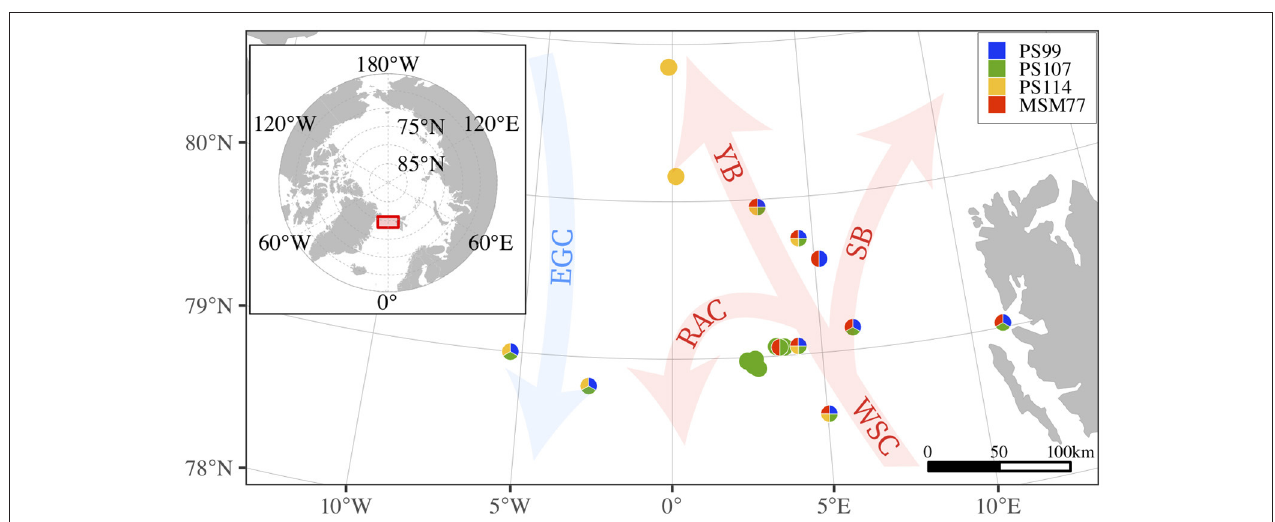
Frontiers in Marine Science |